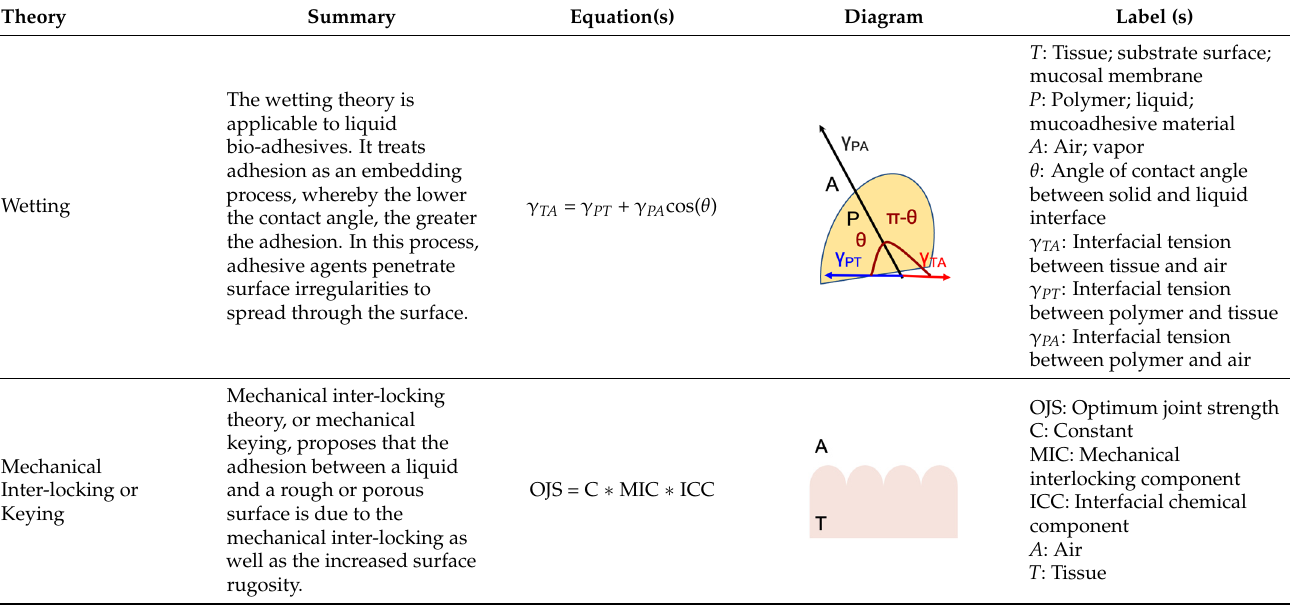
Table 1. Summary of the Major Muco-Adhesion Theories.